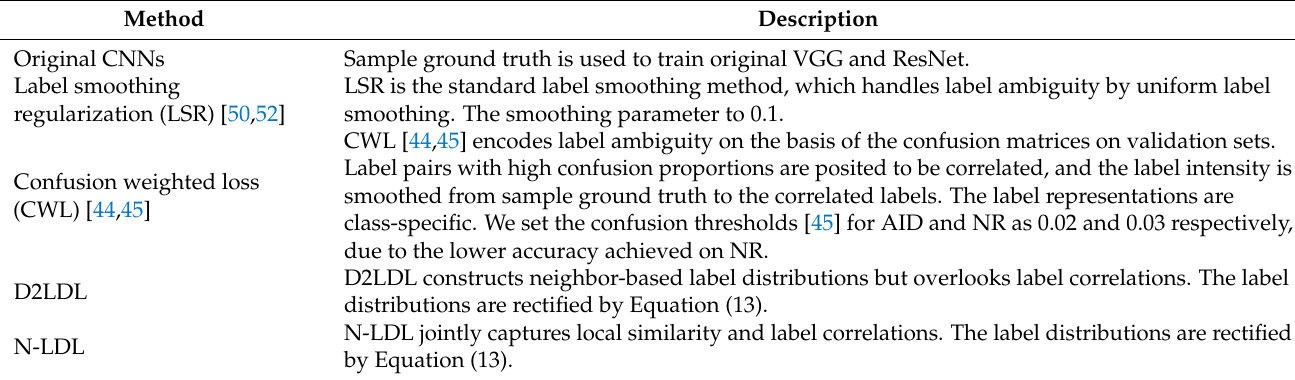
Table 2. Methods for constructing label representations of training samples. Method Figure 9. Distorted distributions produced by our method.